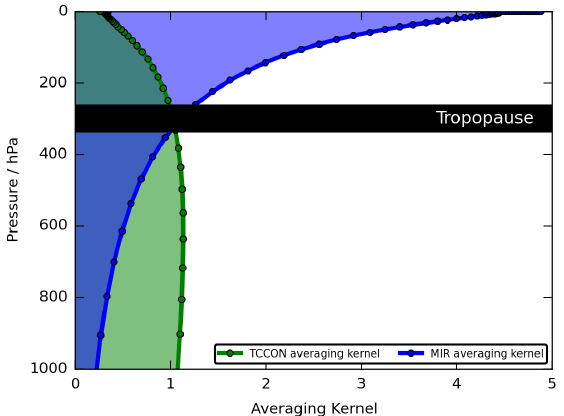
Figure 8. An estimate of the magnitude of the averaging kernel smoothing correction as described in Eq. (4) for the Ny-Ålesund time series of the 2600cm − 1 windows with CarbonTracker 2013 as a true atmospheric